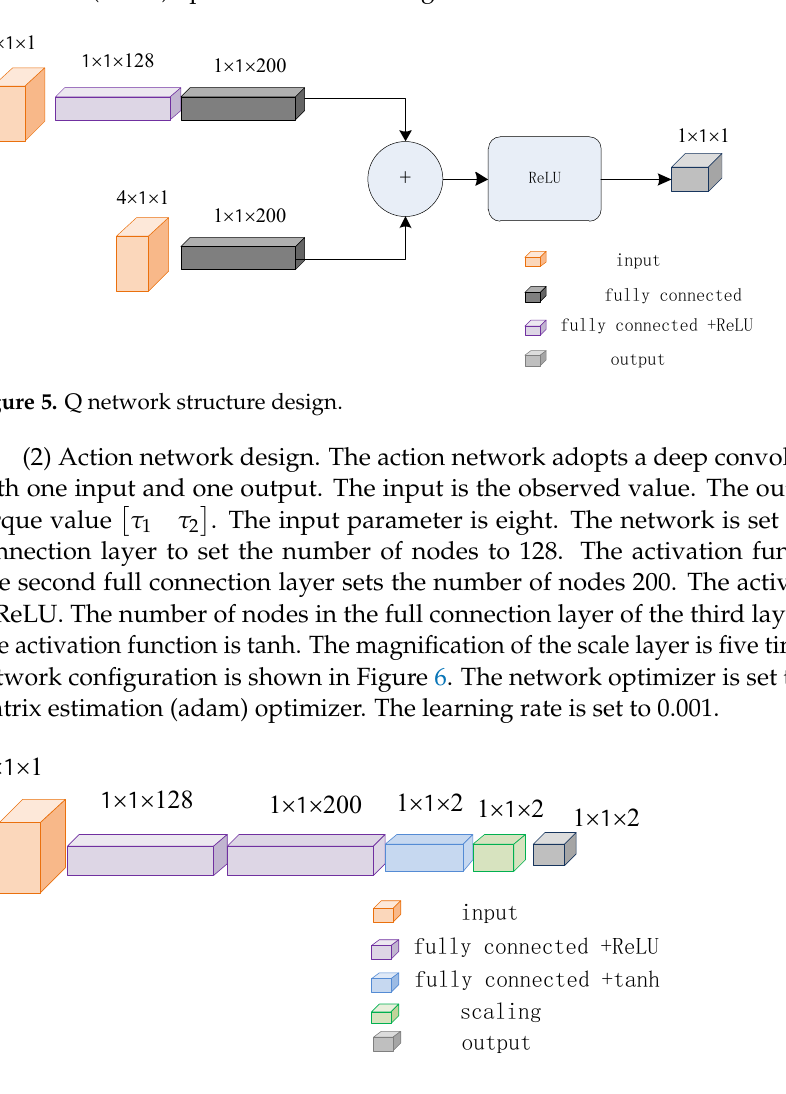
Figure 6. Action network structure